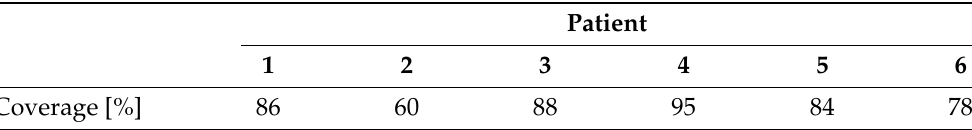
Figure 15. ( a ) Low disturbance level and ( b ) high disturbance level in raw flow signals. Table 8. Coverage of successful